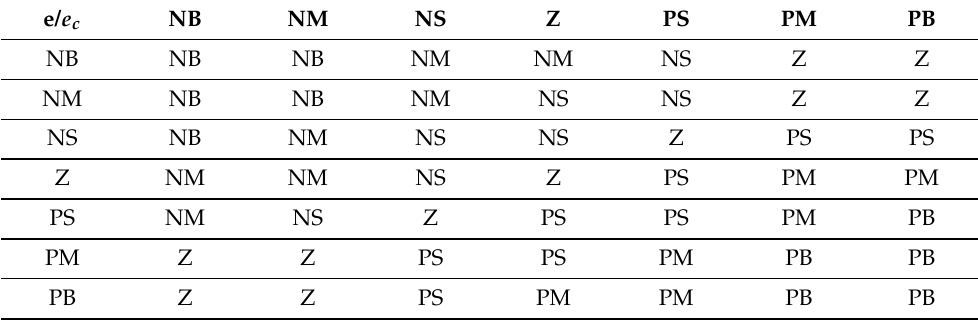
Table 6. K d fuzzy control rules.